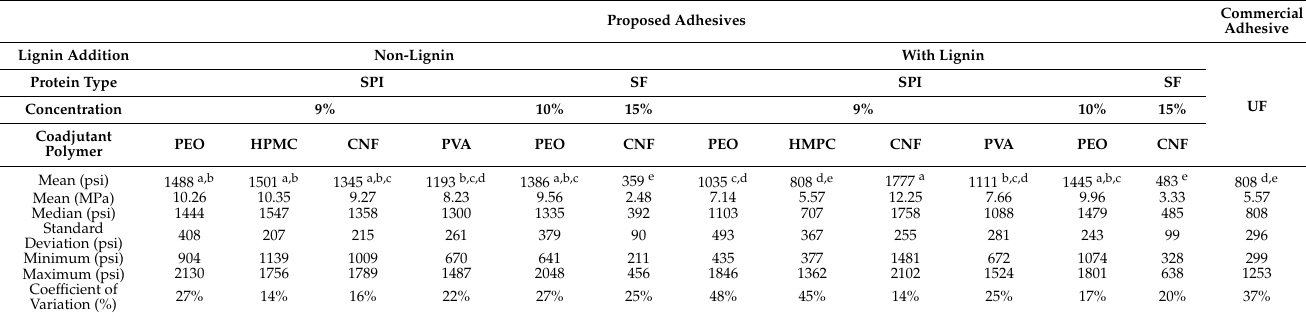
Table 1. Analyzed data of strength at break of southern yellow pine according to the type of tested adhesive. ProposedAdhesives